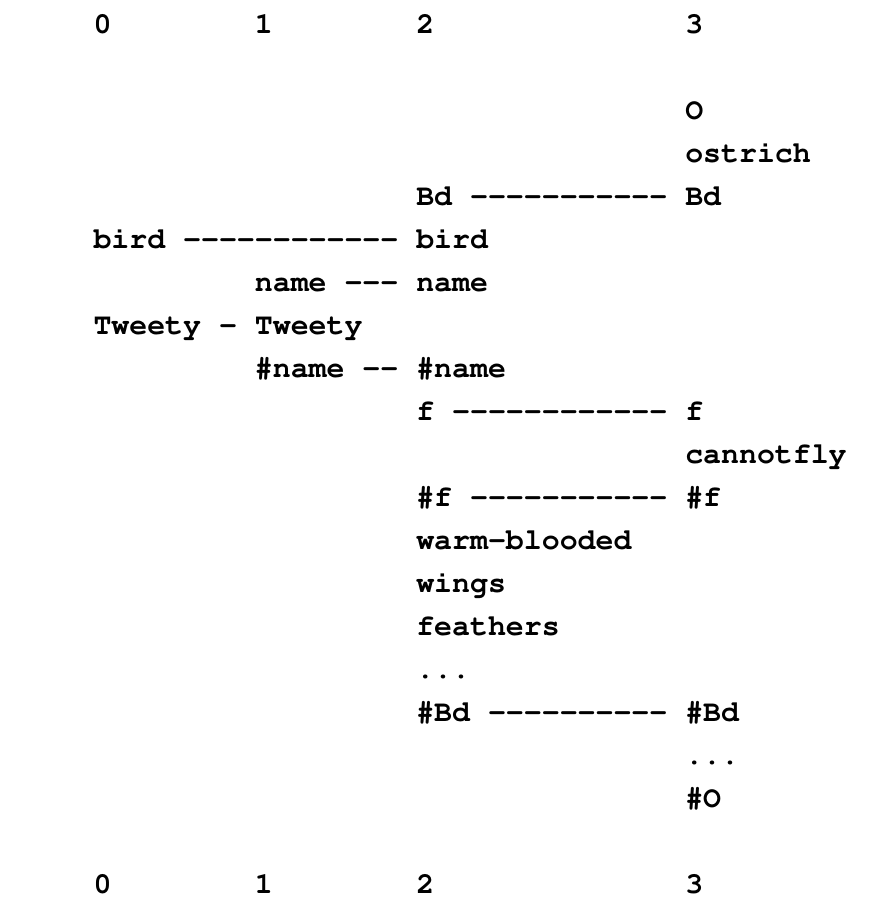
Figure 18. The second of the three best multiple alignments formed by the SP model with “ bird Tweety ” in New and patterns in Old, as described in the text. The relative probability of this multiple alignment is